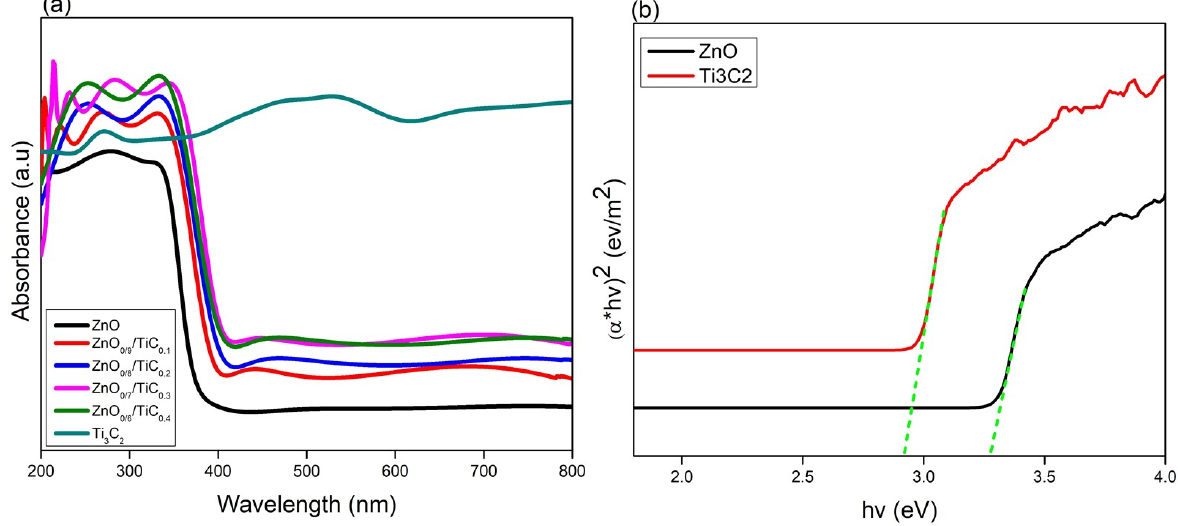
Figure 3. ( a ) UV–Vis spectra of ZnO, Ti 3 C 2 and ZnO/Ti 3 C 2 composites; ( b ) Tauc plot of ( α *h V ) 2 vs. energy (h V ) of ZnO and ZnO 0.7 /TiC 0.3 composite. energy (hV) of ZnO and ZnO 0.7 /TiC 0.3